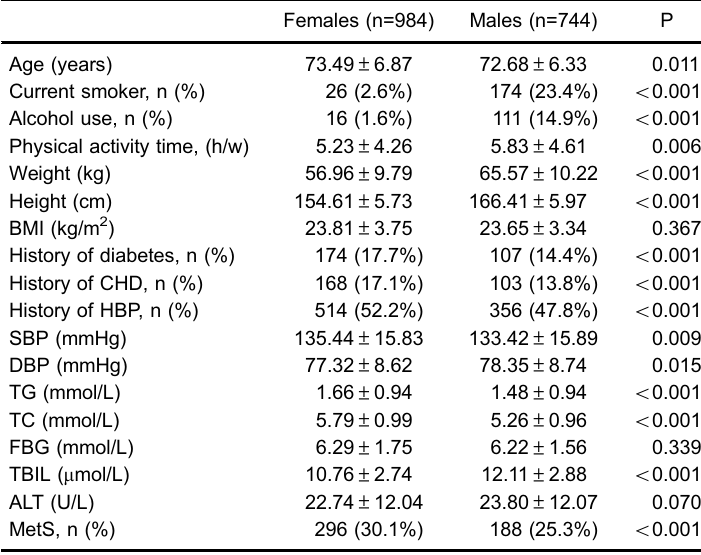
Table 1. General characteristics study